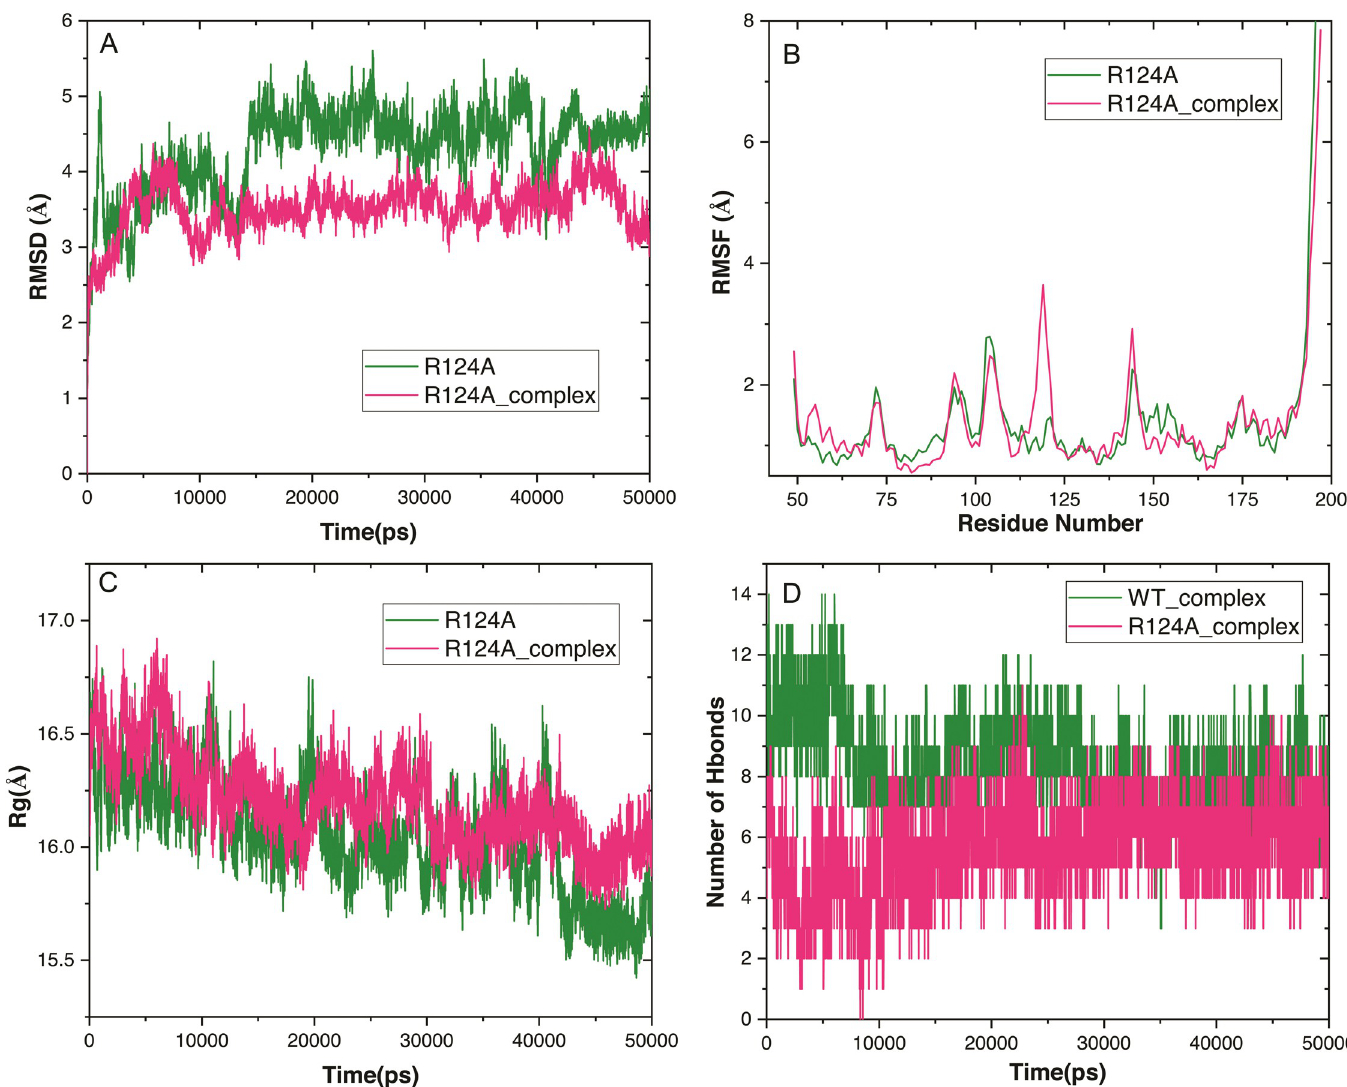
Fig 9. Conformational stability of YBMV CP of R124A_Apo and R124_Complex through MD simulation. (A) Backbone RMSD ( B ) C-alpha RMSF YBMV CP ( C ) Radiation of gyration for YBMV CP; ( D ) comparison of Hydrogen bond analysis between wild type and R124A mutant over 50 ns period concerning the index of the